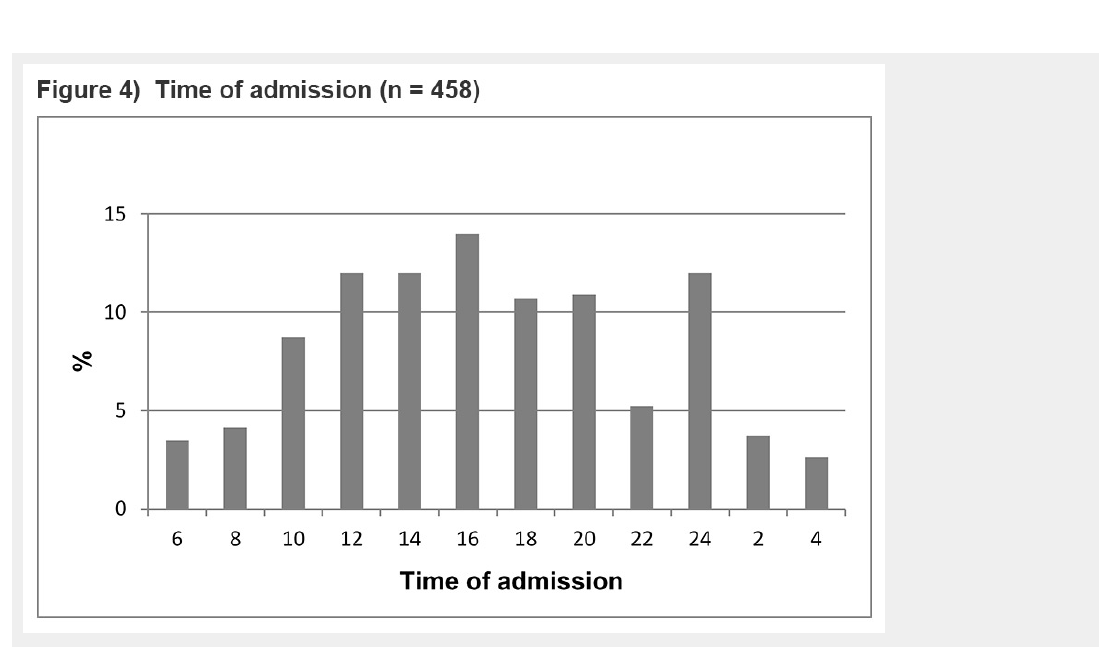
Figure 3 Distribution of admissions over the week (n = 458).